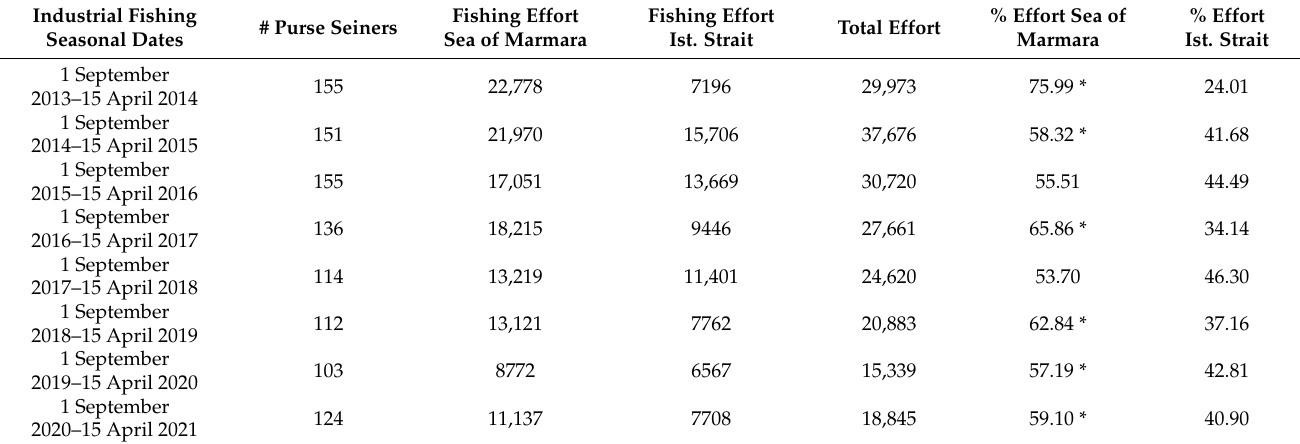
Table 5. Fishing effort in total hours for the Sea of Marmara and the Istanbul Strait. * Indicates statistically different efforts in the Sea of Marmara and Istanbul Strait (# number of